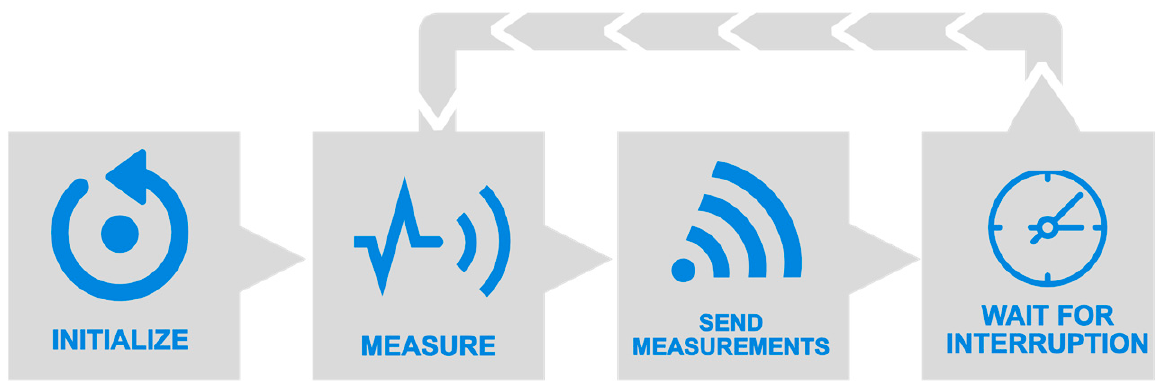
Figure 6. The high-level flowchart of the program running in the microcontroller.